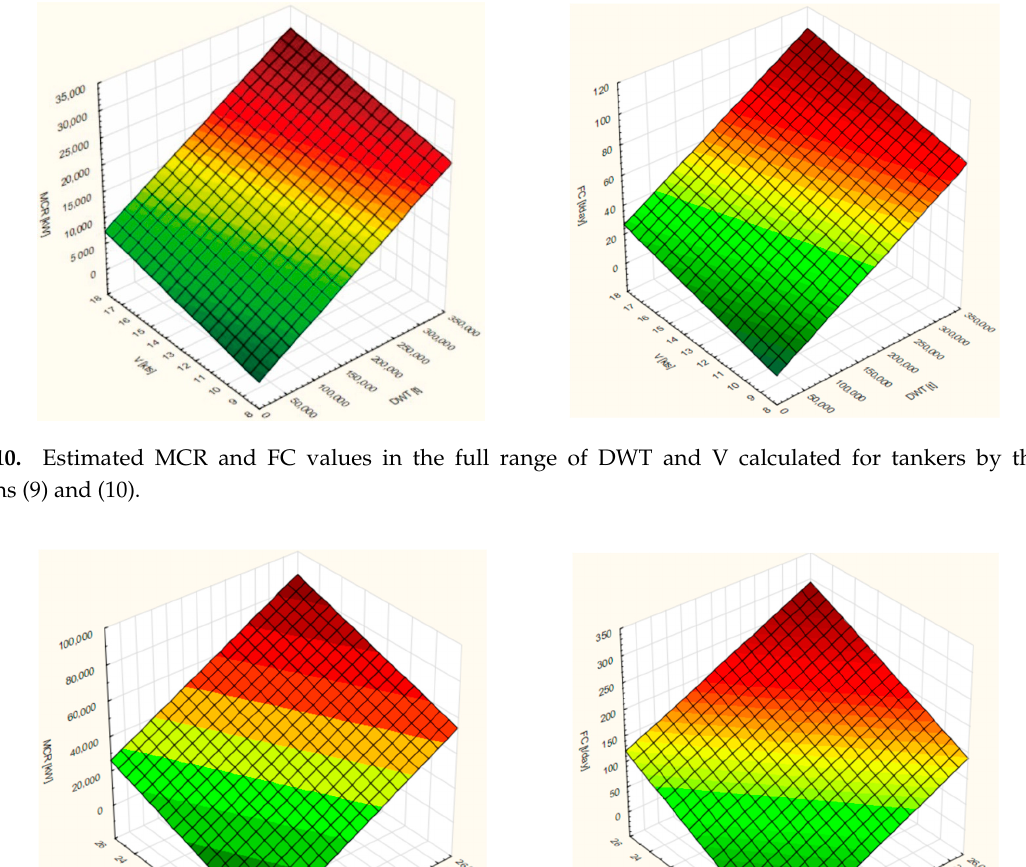
Figure 11. Estimated MCR and FC values in the full range of TEU and V calculated for container carriers by the use of Equations (11) and (12).